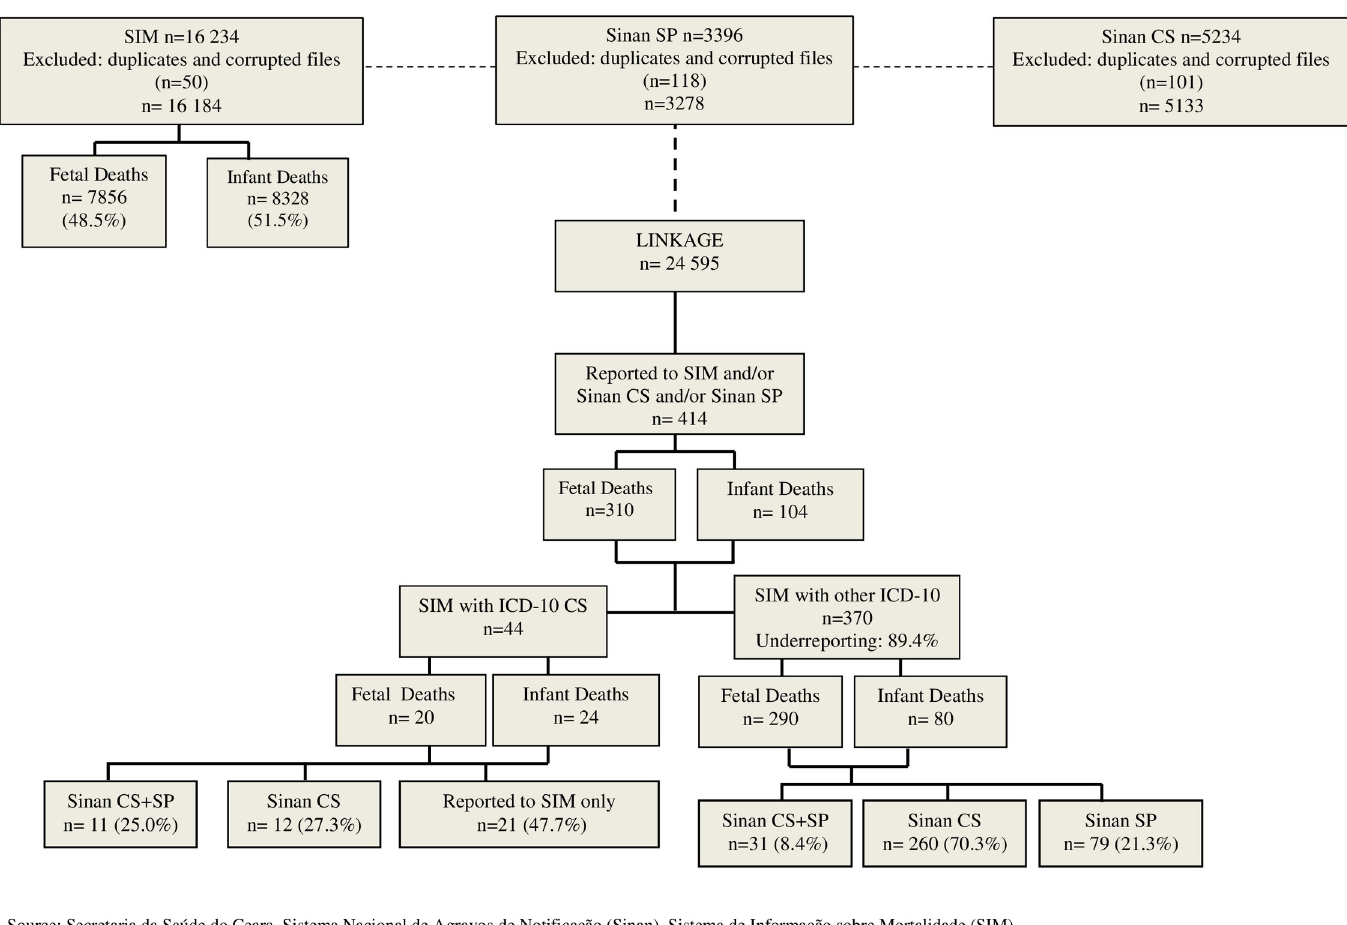
Fig 1. Deterministic record linkage between the Sistema de informac¸ ã o sobre mortalidade (SIM), Sistema de Informac¸ ã o de Agravos de Notificac¸ ã o (Sinan) Congenital Syphilis and the Sinan Syphilis in Pregnancy databases. Ceara´, Brazil, 2010–2014.